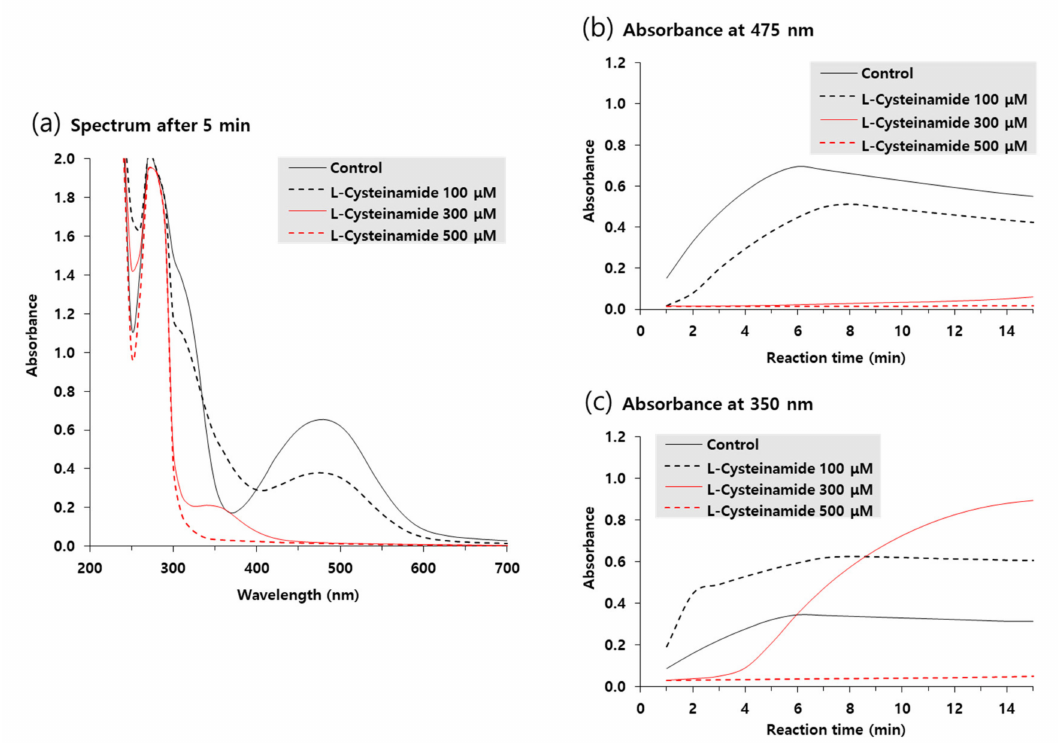
Figure 8. Ultraviolet-visible absorption spectrum changes during TYR-catalyzed reactions. The reaction mixture containing 2 mM L-DOPA and varied concentrations of L-cysteinamide (100, 300, or 500 µ M) were incubated at 25 ◦ C for the indicated time. Spectra after 5-min reaction are shown in ( a ). Time-dependent changes in A 475 and A 350 are shown in ( b ) and ( c ),